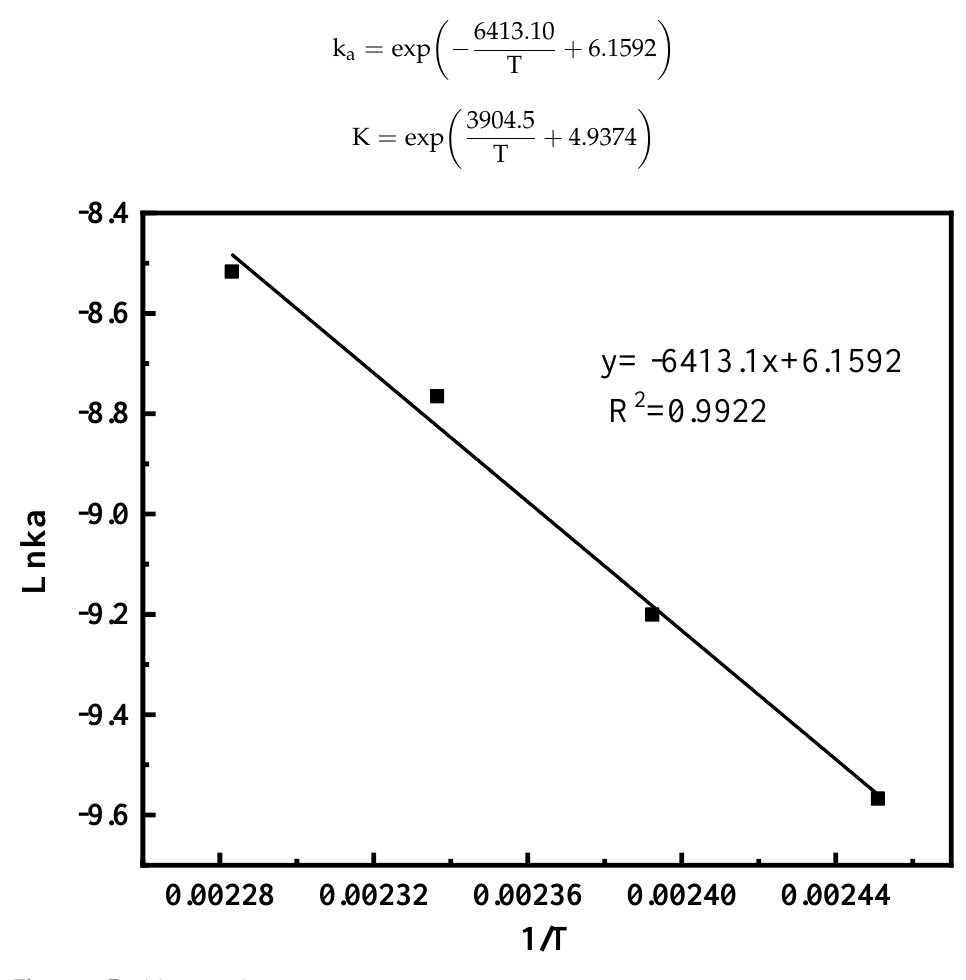
Figure 6. Positive reaction rate constant versus temperature.